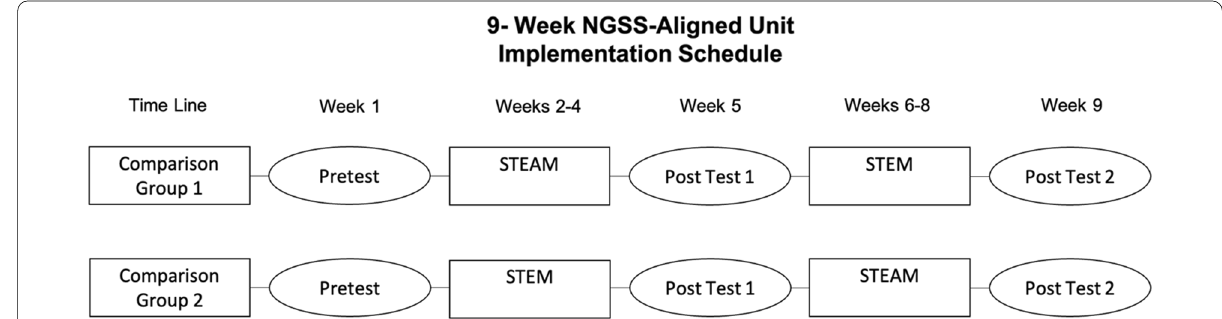
Fig. 1. 9-week NGSS Implementation Schedule. This figure shows the implementation schedule of the treatment crossover research design. Students start off by taking a pretest and are assigned to their STEM and STEAM cohorts. After 3 weeks, student then take post-test 1. Then, the treatment groups crossover accordingly. After three more weeks, students conclude by taking the post-test